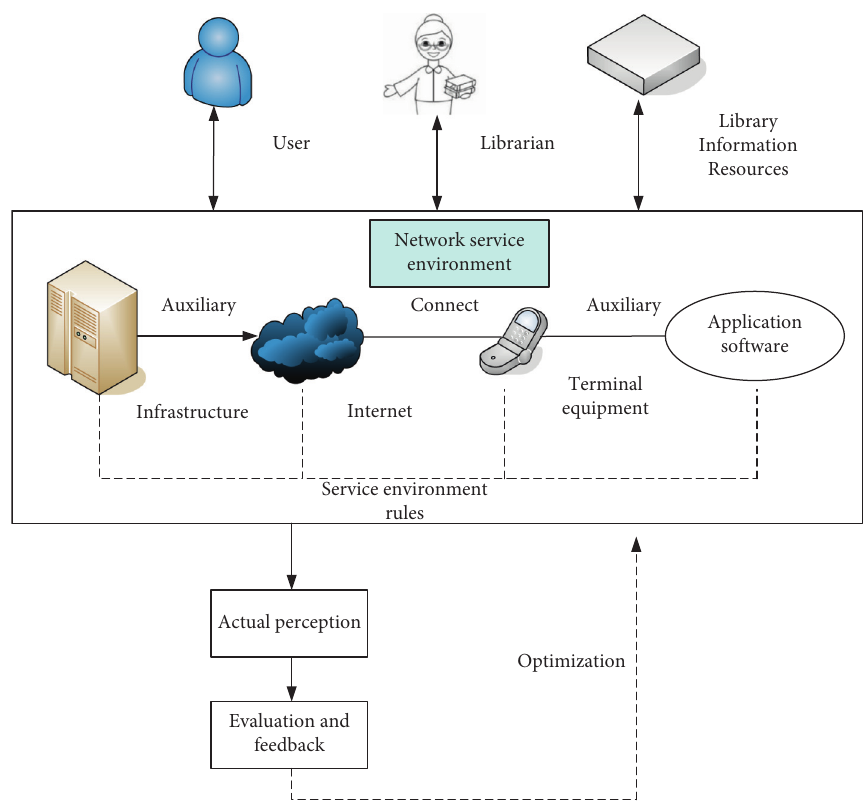
Figure 7: Interaction and optimization design with network service